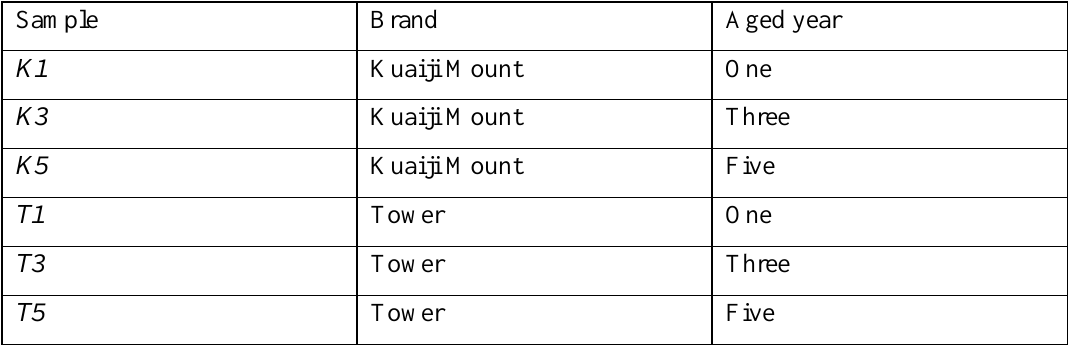
Table 1 . Chinese yellow wine samples under